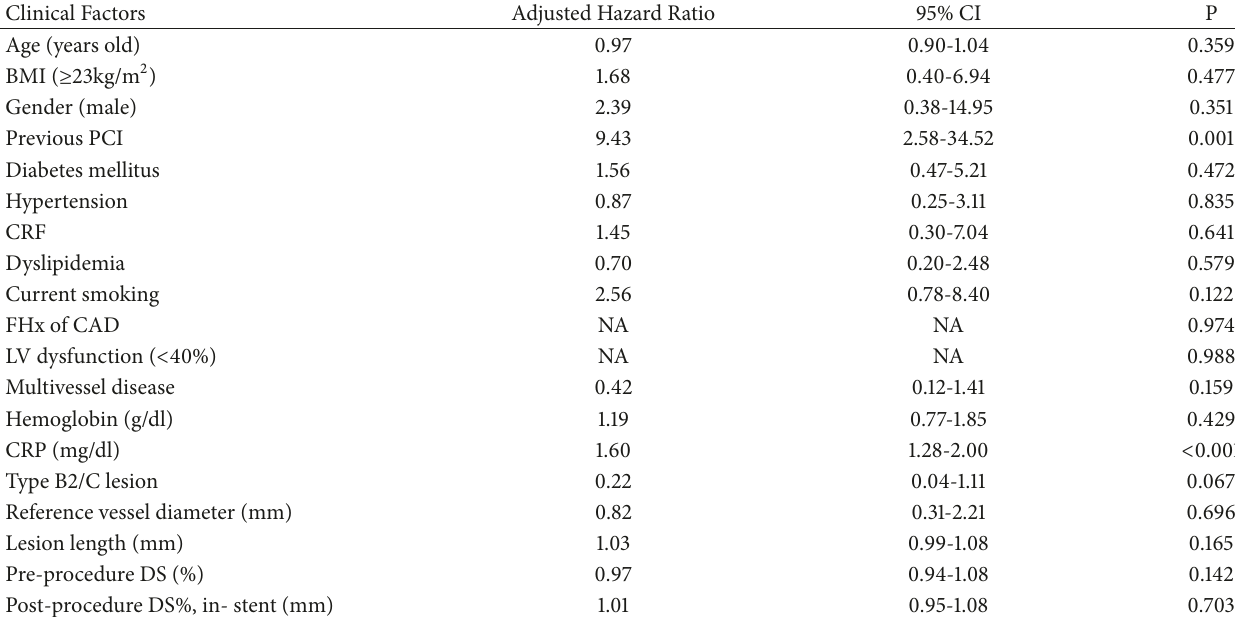
Table 4: Predictors of late